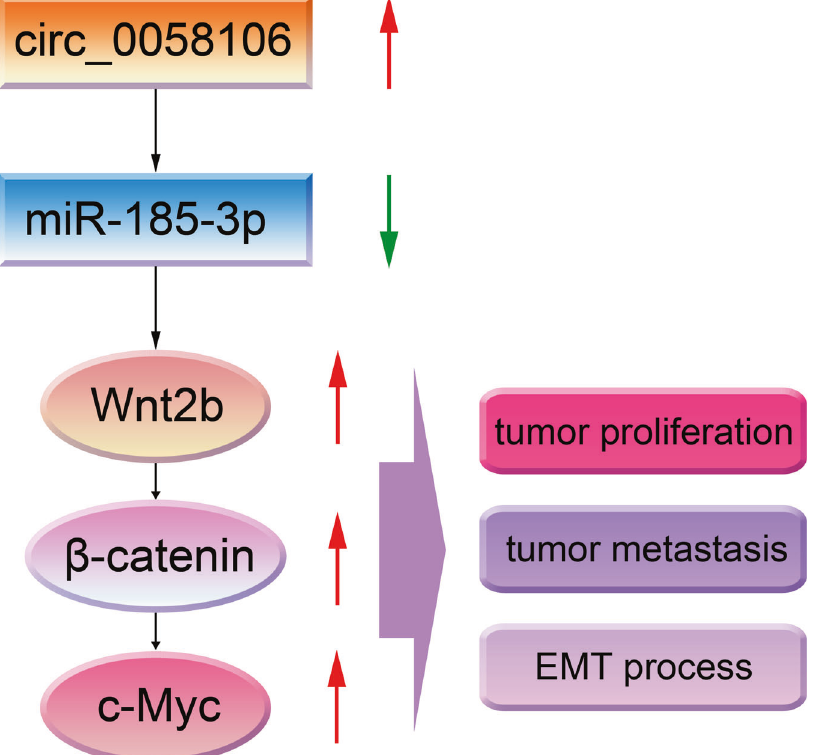
Fig. 9 Diagram depicting the proposed role of circ_0058106 in HSCC. Circ_0058106 promotes proliferation, metastasis and EMT process by regulating Wnt2b/ β -catenin/c-Myc pathway through miR-185-3p in HSCC. Cell Death and Disease (2021)